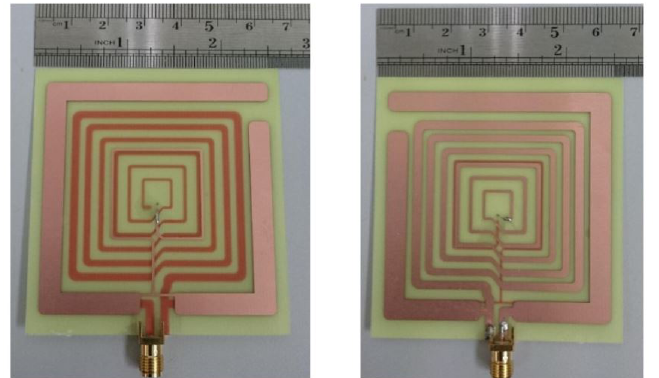
Figure 11. Printed spiral antenna proposed in [48]: top view ( left ) and bottom view ( right ).